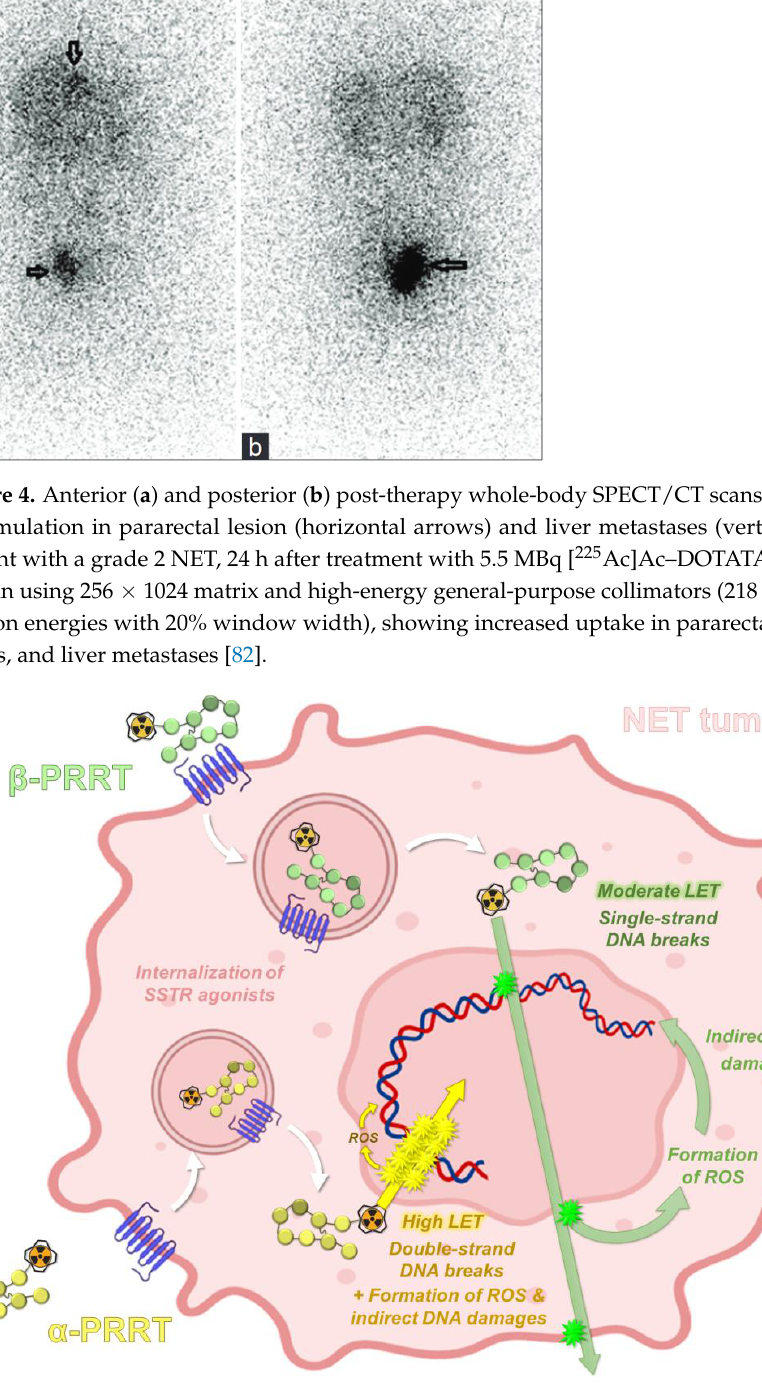
Figure 5. Principle of SSTR-targeting PRRT based on radiolabeled somatostatin analogues. PRRT: peptide receptor radionuclide therapy; SSTR: somatostatin receptors; LET: linear energy transfer; ROS: reactive oxygen species.